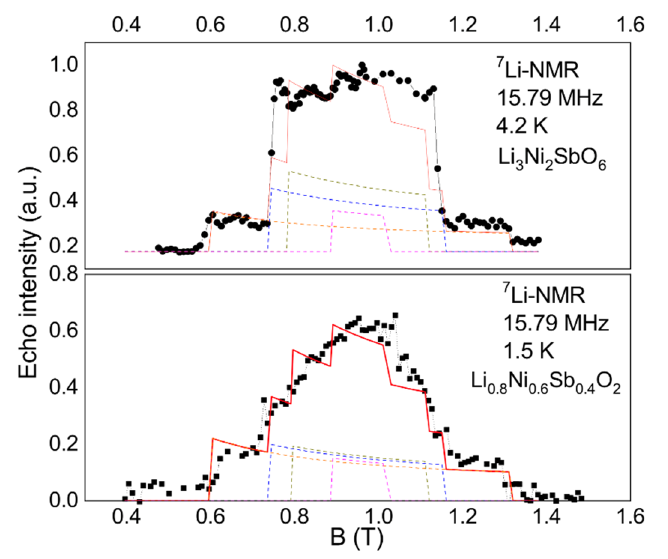
Figure 12. U pper ) The 7 Li spectrum for Li 3 Ni 2 SbO 6 at 4.2 K and B ottom) for Li 2.4 Ni 1. 8Sb 1.2 O 6 at 1.5 K obtained at frequency of 15.79 MHz. The red line is the result of dipole-dipole calculations; dashed lines represent the calculated contribution of different magnetically nonequivalent 7 Li positions in frame of the powder averaging of the zig-zag model.